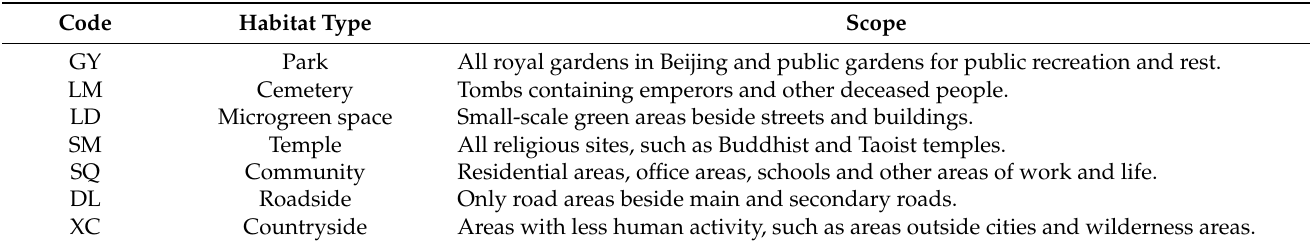
Table 2. Classifications and ranges of large old tree habitats in